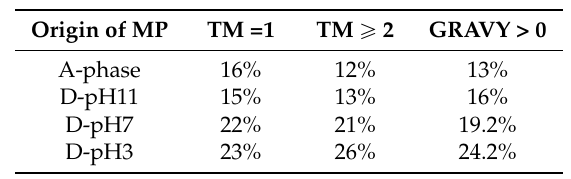
Table 1. Fractional transmembrane domains (TM, obtained with the TMHMM Server, v. 2.0, (Center for Biological Sequence Analysis, Department of Systems Biology, Technical University of Denmark)) and grand average hydrophobicity (GRAVY) of proteins identified from the membrane proteome of cultured mouse myeloma cells fractionated by sequential pH-tuned ND extraction. A-phase presented collective results from the three sequentially pH-tuned extractions with ND.